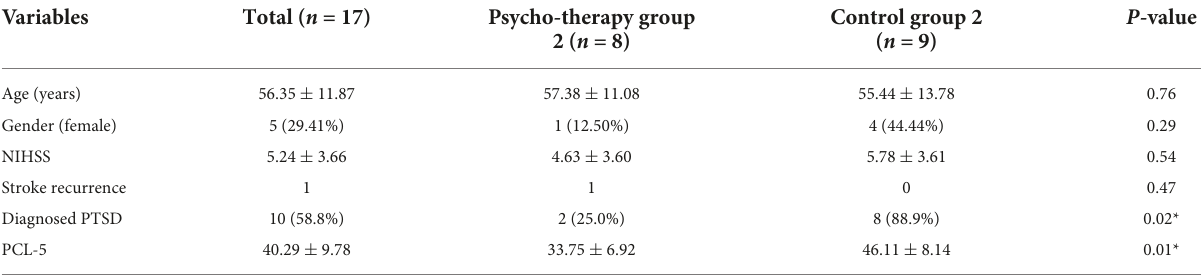
TABLE 4 Characteristics of patients with post-stroke post-traumatic stress disorder (PTSD) at 6-month follow-up.